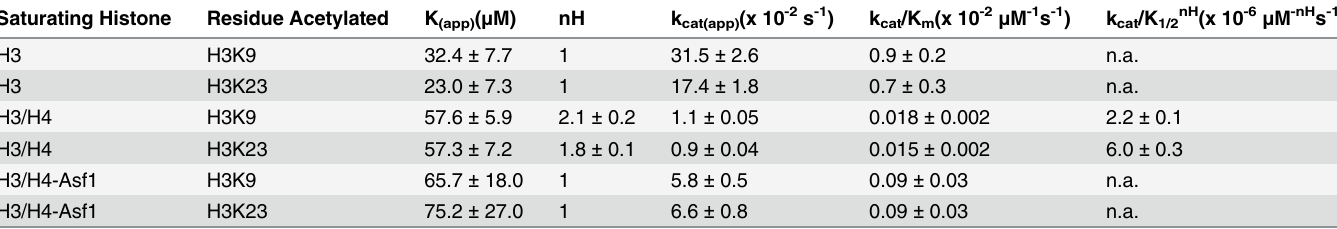
Table 2. Steady-state parameters from kinetic assays of acetyl-CoA titration (mean ± standard